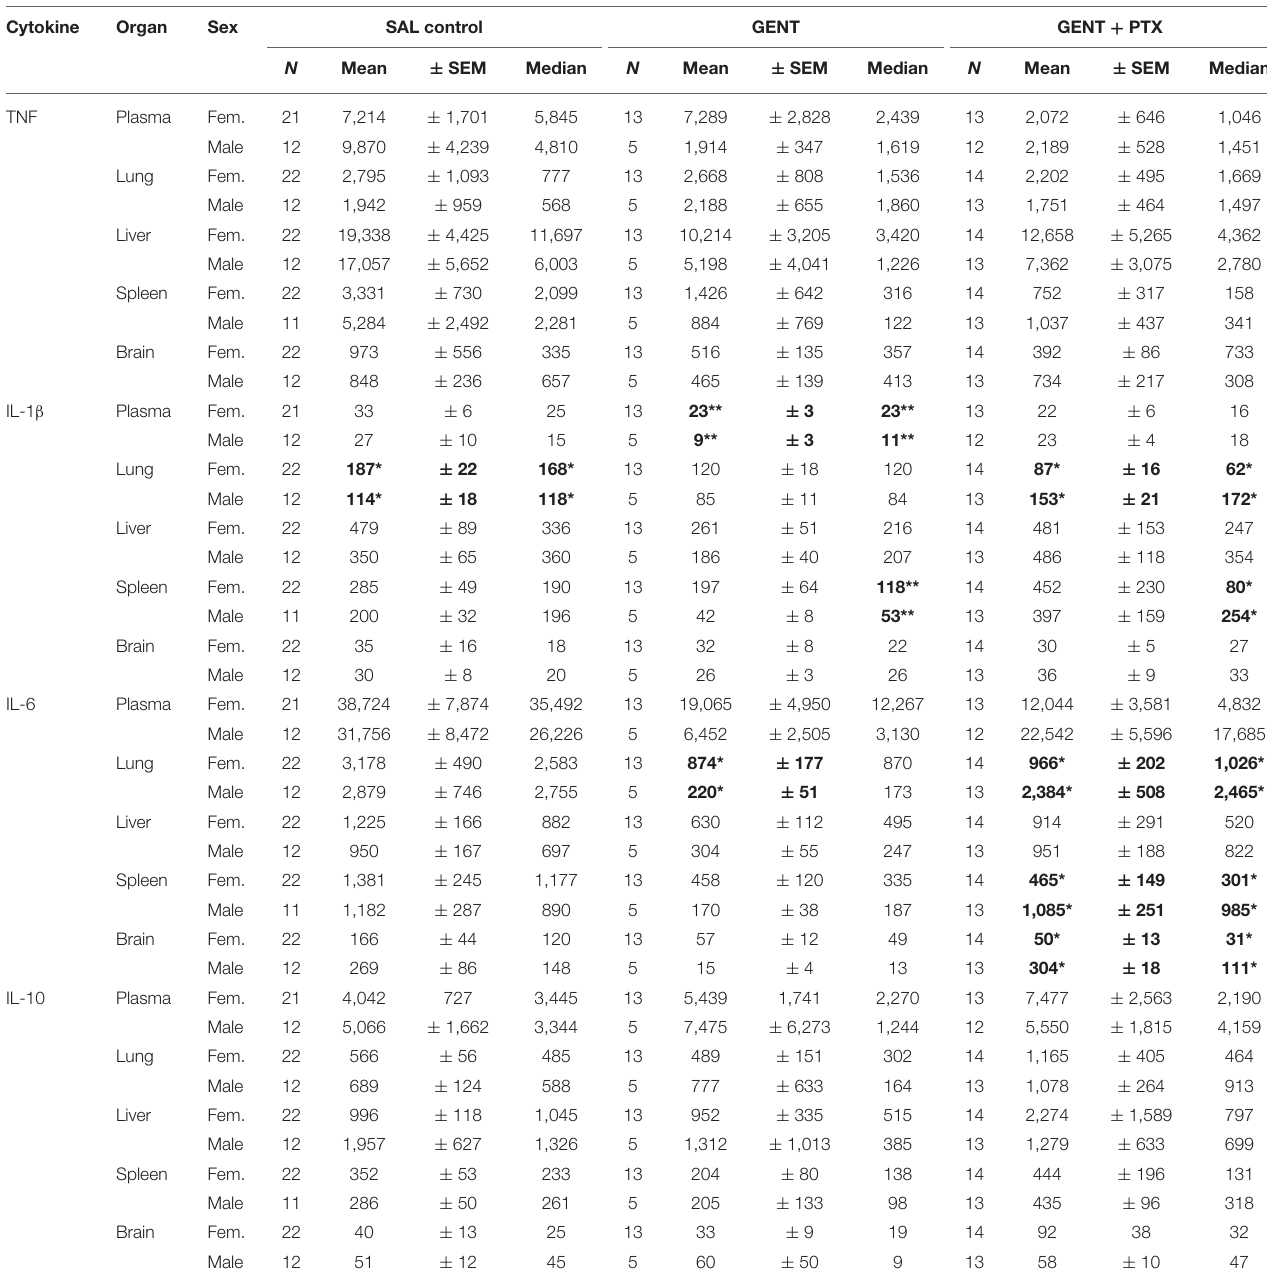
FIGURE 11 | counts, (B) TNF, and (C) IL-10 concentrations for each organ and blood or plasma from animals subjected to different treatment conditions were expressed as a percentage compared to untreated septic mice within the same litter (defined as 100%). Significant differences of relative median (IQR) CFUs and cytokine concentrations of animals treated with antibiotics and/or anti-inflammatory agents vs. untreated controls and between GENT- vs. (G + P)-treated animals were as follows: * p < 0.05, ** p < 0.01, *** p < 0.001, ns, non-significant; Mann-Whitney U (A) and Kruskal-Wallis tests with correction for false discovery rate (B,C) , n = 15–27.